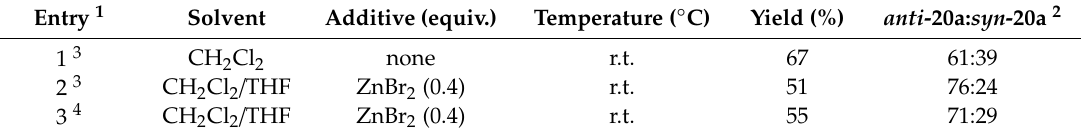
Table 1. Preliminary experiments using ent- 15 , obtained by TEMPO/PhI(OAc) 2 oxidation of ent -14.